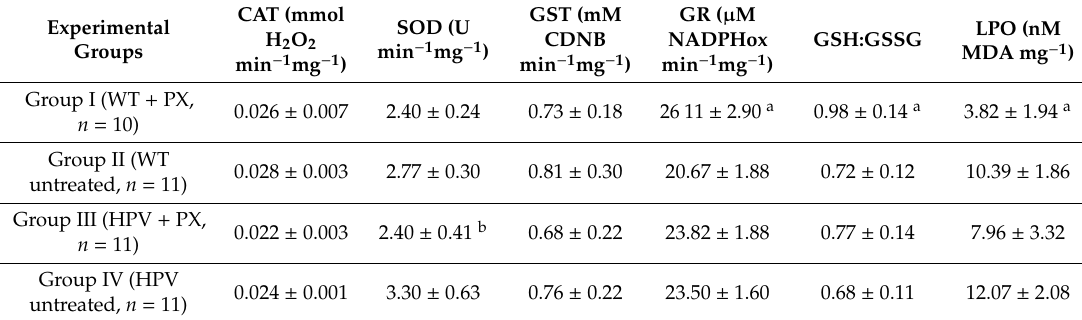
Table 3. Oxidative stress parameters .